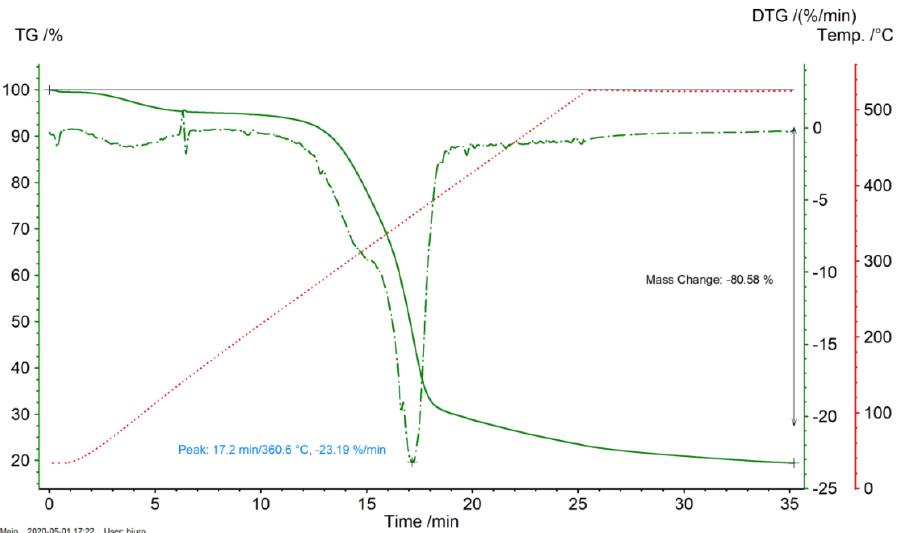
Figure 9. Thermogravimetric analysis of the Miscanthus torrefaction process for the production of biocarbon at a temperature of 525 °C (heating ratio 20 K/min) in an N 2 atmosphere.